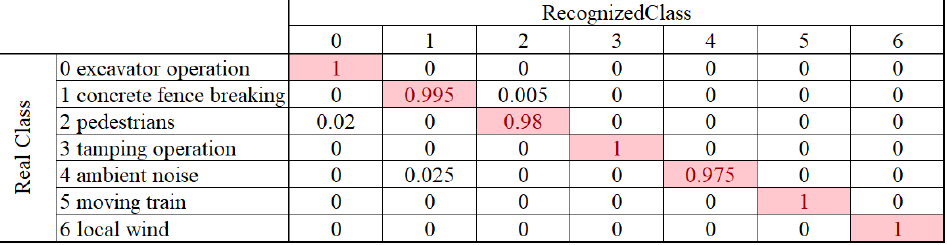
Figure 24. Confusion matrix of multi-class event identification. Reproduced with permission from our previous paper [3], published by Optical Society of America, 2019.